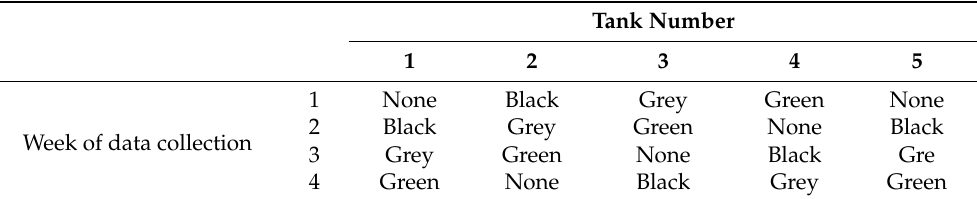
Table 1. The rotation of colored acrylic sheets acting as backgrounds for the tanks over the data collection period. None refers to the lack of background, which also acted as a control